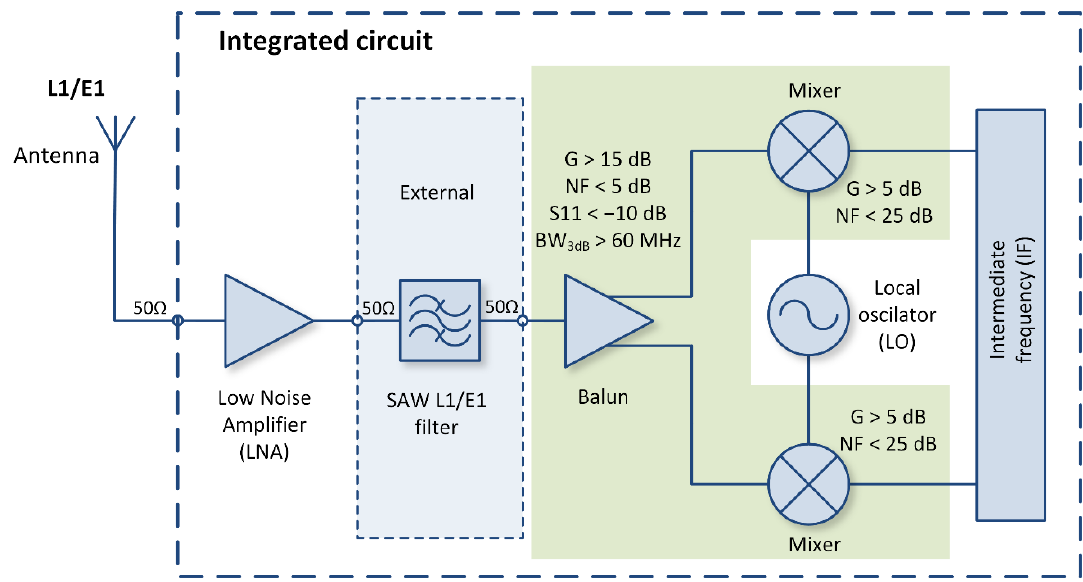
Figure 1. Block diagram of the analog frontend GNSS radio block and block specification (the shaded part is presented and discussed in this article).